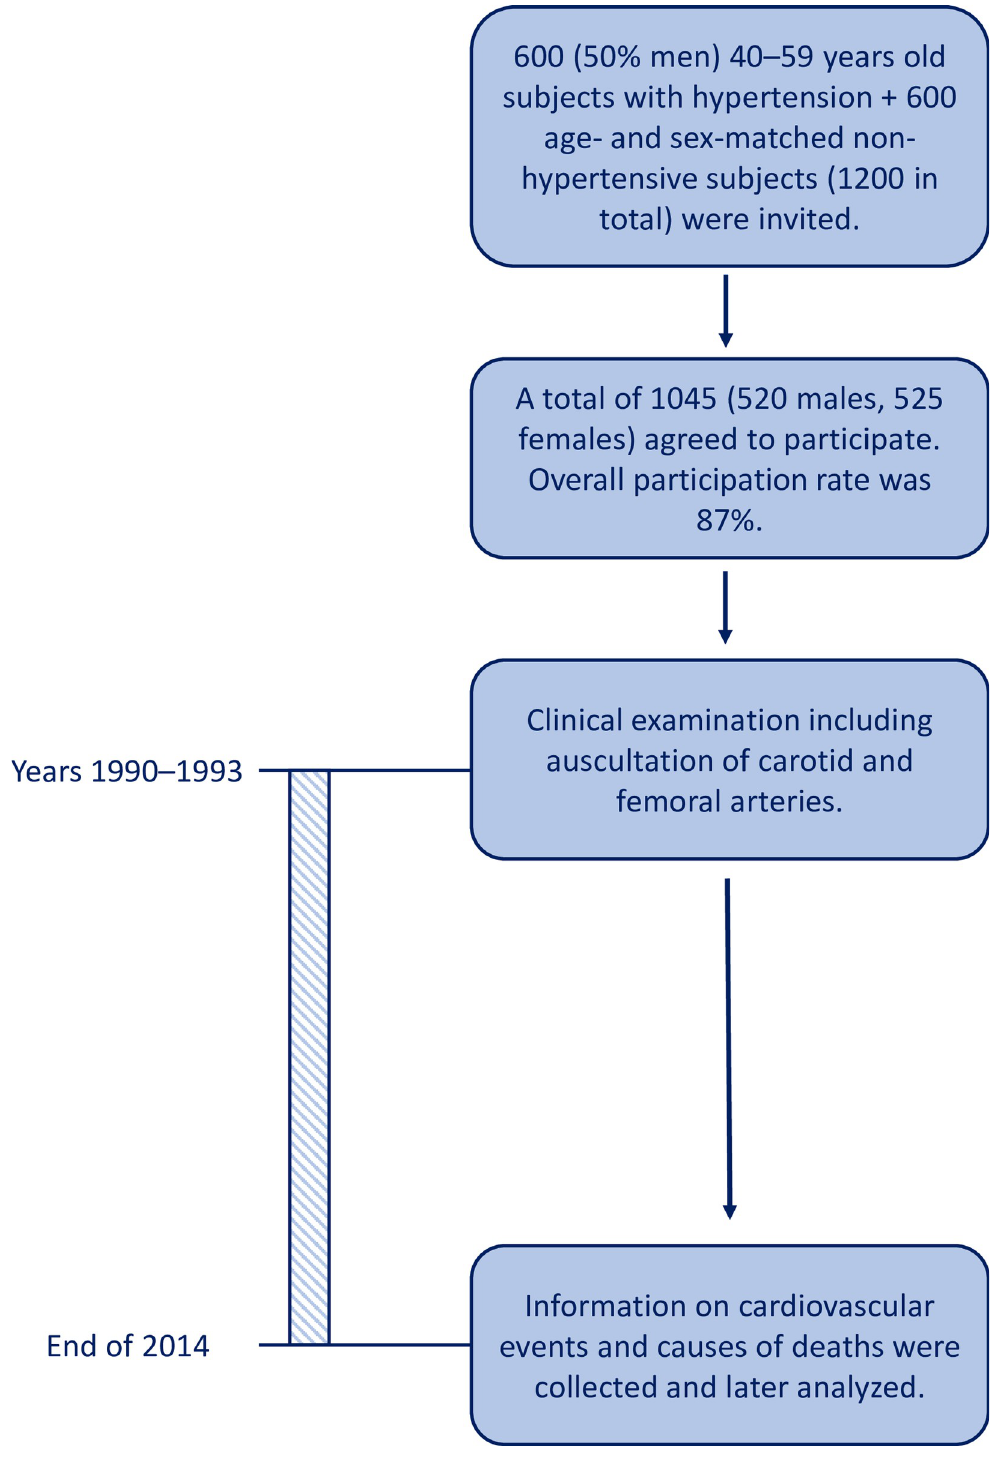
Fig 1. Flow chart of participant recruitment and